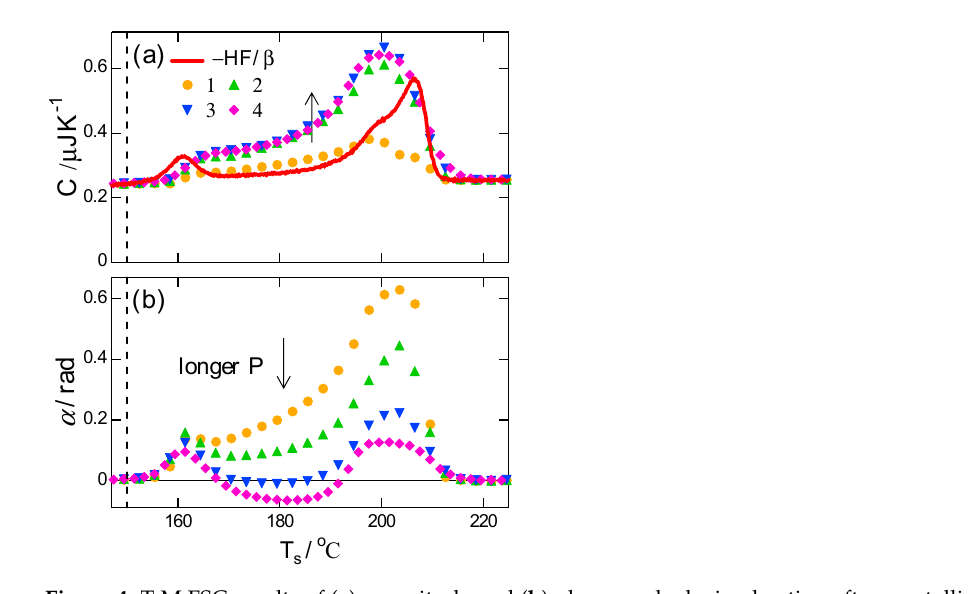
Figure 4. T-M FSC results of ( a ) magnitude and ( b ) phase angle during heating after crystallization at T c = 150 ◦ C (vertical broken line) for 5 s. β = ∆ T 0 / P = 100 K s − 1 . with ( ∆ T 0 / P ) /K s − 1 = 1 : 3/0.03, 2 : 6/0.06, 3 : 9/0.09, 4 : 12/0.12. Solid line in ( a ) represents − HF/ β .